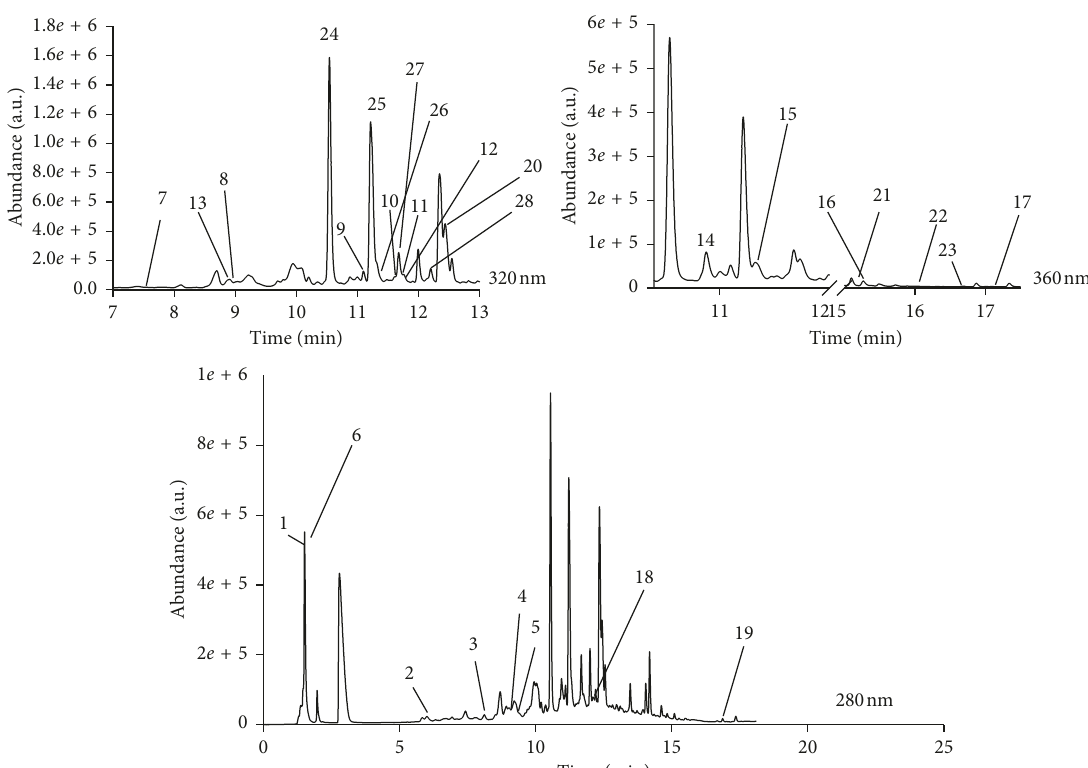
Figure 2: UPLC-UV chromatograms of Buddleja scordioides extract recorded at 280, 320, and 360nm. Numbers correspond to the compounds listed in Table 2.